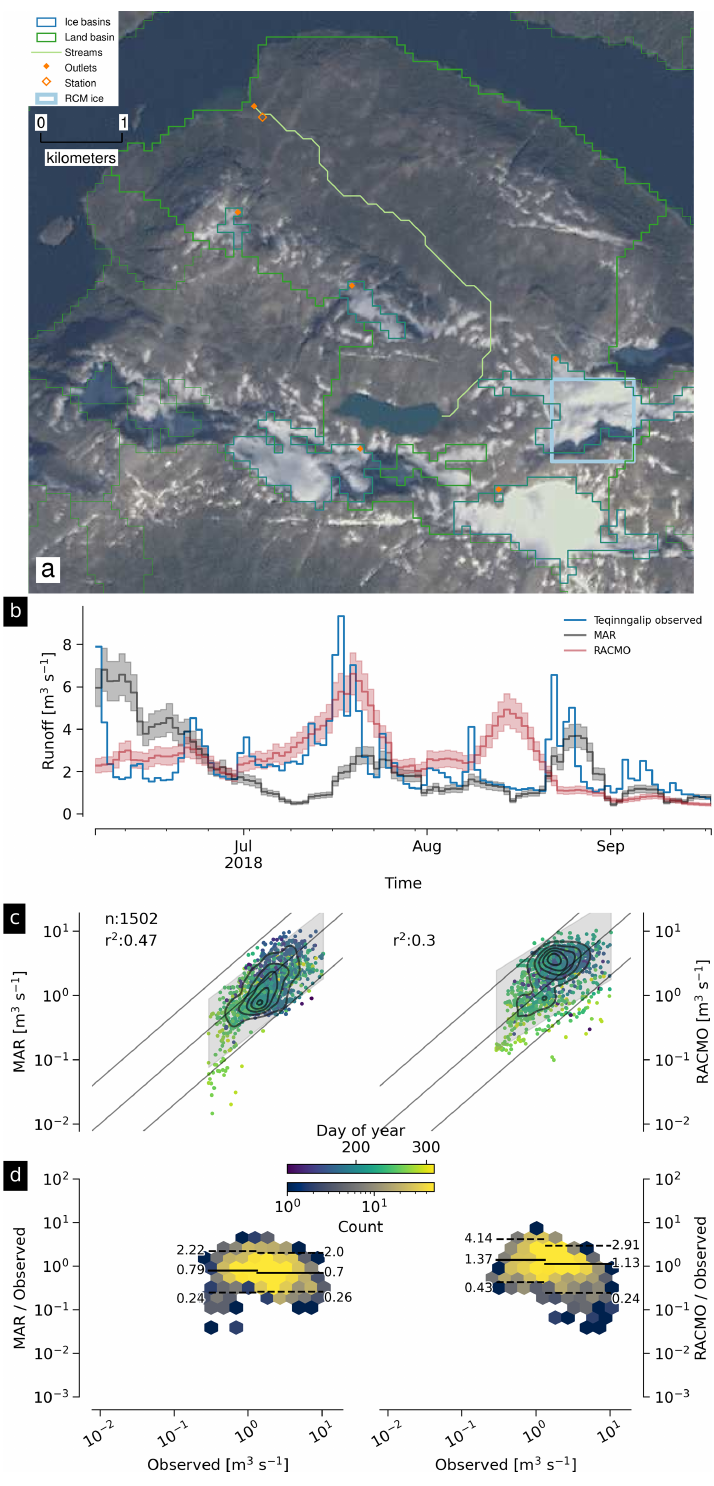
Figure 13. Graphical summary of Teqinngalip outlet, basin, and discharge (T in Fig. 1). See Sect. 3.4 for a general overview of graphical elements and Sect. 4.2.5 for discussion of the Teqinngalip basin. Basemap from Howat et al. (2014) and Howat